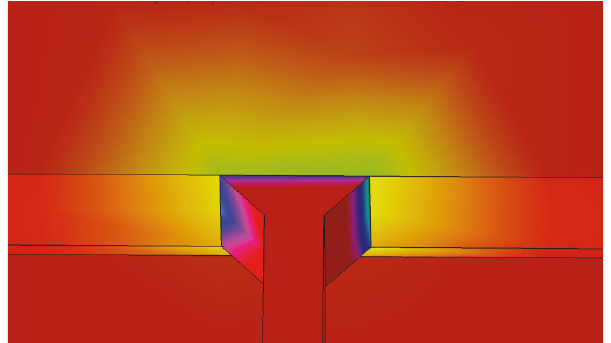
Figure 5: PML-based energy propagation of the anchor damping at the connection between the beam and anchor.